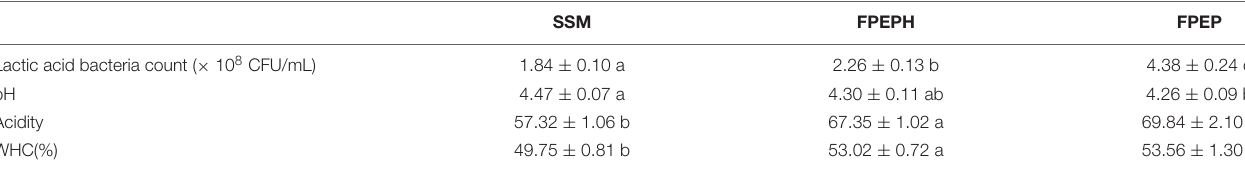
TABLE 2 | Physicochemical properties of sour soybean milk.